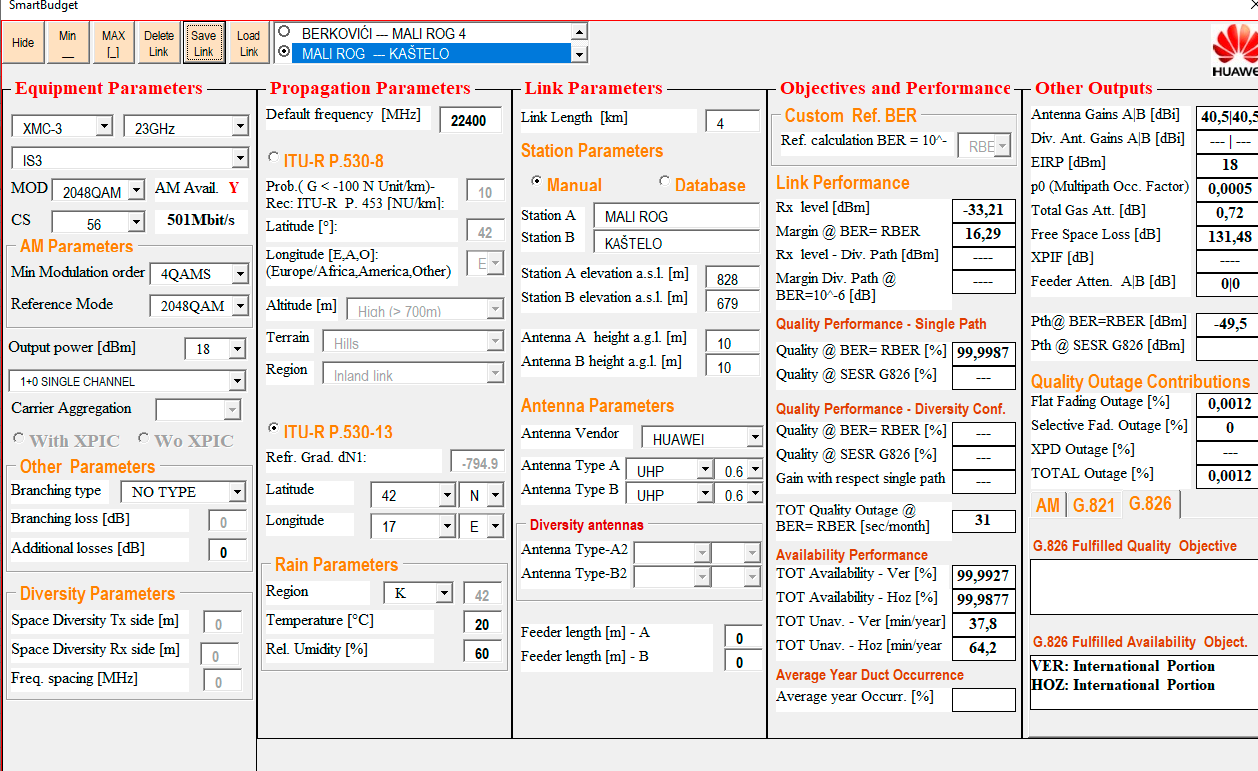
Figure 14. Prediction for the fourth RR section; 2048 QAM, 500 Mb/s.